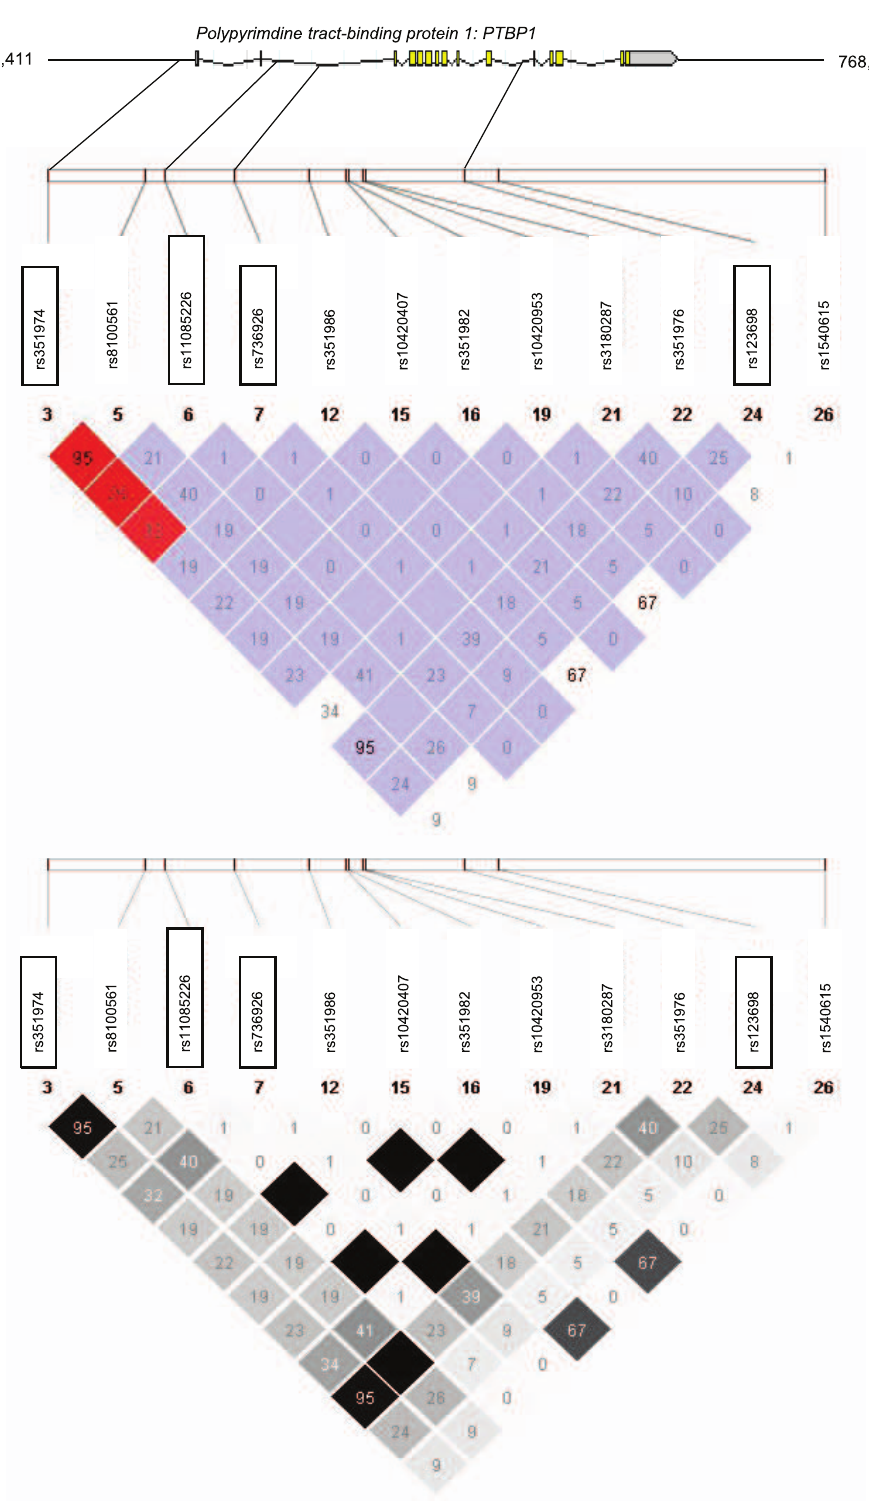
Figure 1. Genomic region of human chromosome 19p13.3 harboring the PTBP1 gene and HapMap linkage disequilibrium data of common (MAF . 5%) informative SNPs within this locus. The PTBP1 gene consists of 15 exons and 14 introns. It spans 14.92 kb from nucleotide 748,411 to 763,327. The analyzed locus included 5 kb of both the 5 9 - and the 3 9 -flanking regions. The locations of the four tagging SNPs are marked by frames. The upper panel shows D 9 values and the lower panel shows r 2 values (black diamonds without values: r 2 =1.0).